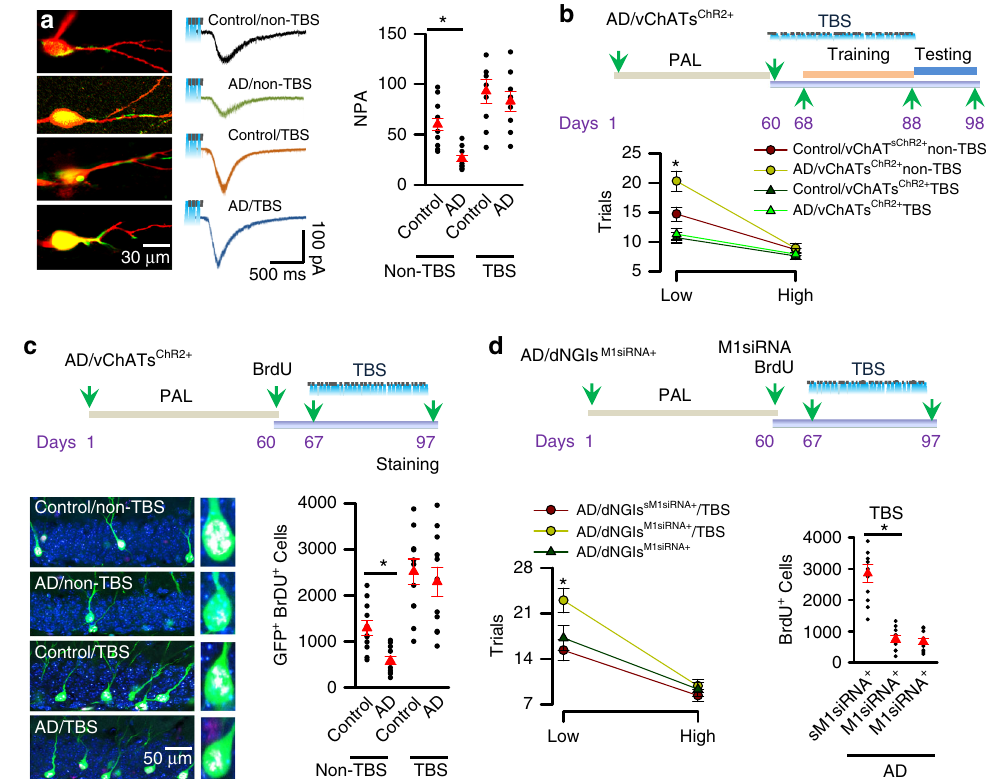
Fig. 7 TBS improves spatial pattern separation in AD mice. a Representative images (left) and recording (middle) from the individual dNGIs (green) fi lled with Lucifer yellow (red) through the recording electrodes in slices (left) from AD/vChATs ChR2+ and control/vChATs ChR2+ mice treated without (non- TBS) or with TBS. The cholinergic synaptic currents were evoked by illuminating vChATs at an intensity of 5 mV. A plot (right) shows the actual (black circles) and averaged values (red triangles) of the normalized peak amplitude (NPA) of the currents at an intensity of 5 mV. The peak currents were normalized to those evoked by an intensity of 1 mV (de fi ned as 1.0, mean ± SEM, n = 9 mice/group, F 1.35 = 10.91, * p = 0.0019, two-way ANOVA). b Experimental schedules show that AD/vChATs ChR2+ mice at 80 ± 2 days old of age were performed with PAL. After the completion of PAL, the mice were treated with 28-days TBS. A plot (bottom) shows the trials required to reach a criterion in AD/ChATs ChR2+ and control/vChATs ChR2+ mice treated without (non-TBS) or with TBS at a low or a high separation (mean ± SEM, n = 11 mice/group, F 1.43 = 7.99, * p = 0.00072, two-way ANOVA). c Experimental schedules and representative images and the actual (black circles) and averaged numbers (red triangles) of GFP + BrdU + cells in the individual AD/ ChATs ChR2+ and control/vChATs ChR2+ mice treated without (non-TBS) or with TBS (mean ± SEM, F 1.35 = 38.93, * p = 0.00081, n = 9 mice/group, two-way ANOVA). d Experimental schedules (top) show that AD/dNGIs M1siRNA+ mice at 80 ± 2 days old of age were performed with PAL. After the completion of PAL, mice were administered with a single dose of BrdU and M1siRNA virus. BrdU staining was done immediately after TBS. The trials (bottom) required to reach the criterion at a low or a high separation (mean ± SEM, n = 11 mice/group, F 1.32 = 35.07, * p = 0.00097, two-way ANOVA). The actual (black circles) and averaged numbers (red triangles) of BrdU + cells in the individual mice are plotted (mean ± SEM, n = 11 mice/group, F 1.32 = 68.61, * p = 0.00026, two- way ANOVA) Fig. 12a – c) and had no effect on the motor activity, novel object function of AD mice. Hippocampal theta oscillations encode an recognition, body weight (Supplementary Fig. 12d – g) and a PAL animal ’ s position during spatial navigation 26 . Thus, we applied a task (Supplementary Fig. 13), however, it signi fi cantly improved 28-day theta bust stimulation (TBS) paradigm in AD/ the performance of AD/vChATs ChR2+ mice at a low separation of vChATs ChR2+ mice beginning at 150 ± 5 days of age (Fig. 6a). Four groups of mice including AD/vChATs ChR2+ and age- 2-CSD (Fig. 7b) and increased the numbers of BrdU + cells matched control/ChATs ChR2+ mice treated with (TBS) or without (Fig. 7c). (non-TBS) using TBS. TBS was delivered using 0.2-mm optical To determine whether the improvements of spatial pattern fi bers bilaterally onto the vChATs once per day for 28 consecutive separation in AD/vChATs ChR2+ mice that were treated with TBS are due to activation of cholinergic synaptic transmission and the dNGIs survival, we tested whether inhibition of cholinergic synaptic transmission in dNGIs eliminates the protective effects of TBS in AD mice. We knocked down cholinergic M1 receptor vector. Virus particles (2 μ l), including both rAAV1/2-DIO- M1siRNA and Δ G-rabies-ChR2 viruses, were injected into the dDG of AD/dNGIs TAV/G+/+ mice, resulting in the production of AD/dNGIs M1siRNA+ mice, in which M1siRNA and ChR2 were expressed in dNGIs and vChATs respectively. Knocking down